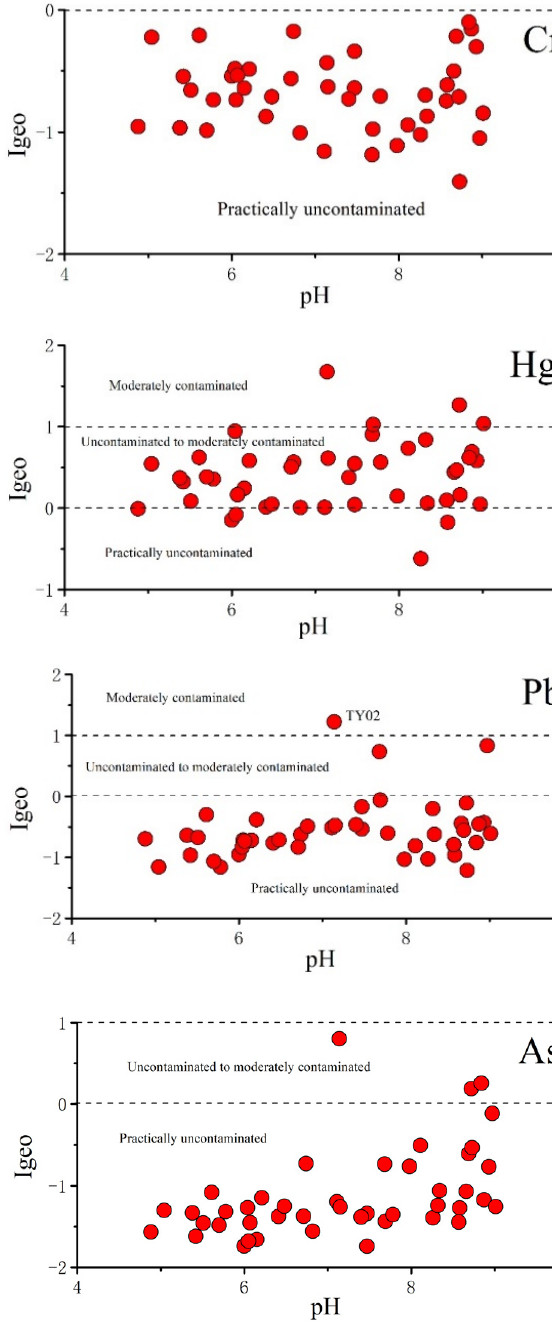
Figure 6. The index of geoaccumulation (I geo ) of soils in the study area.